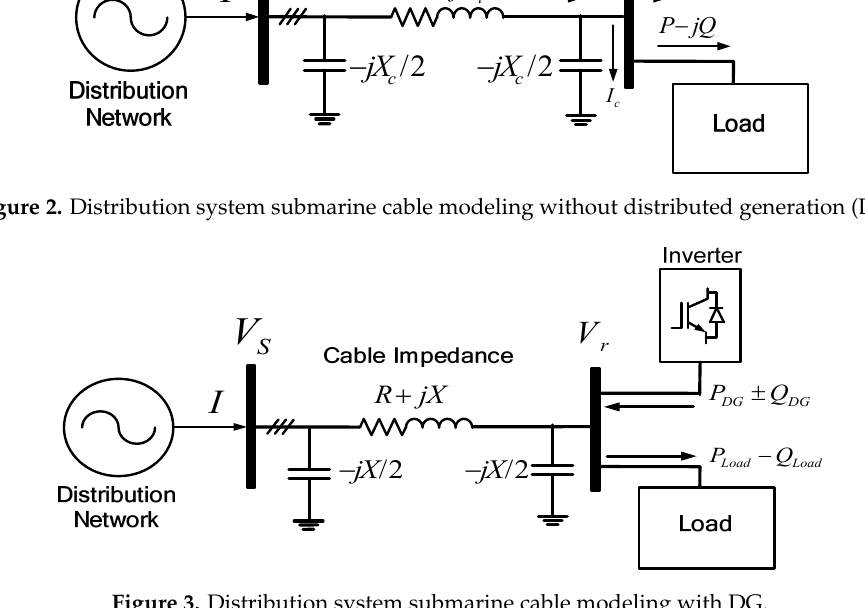
Figure 3. Distribution system submarine cable modeling with DG.